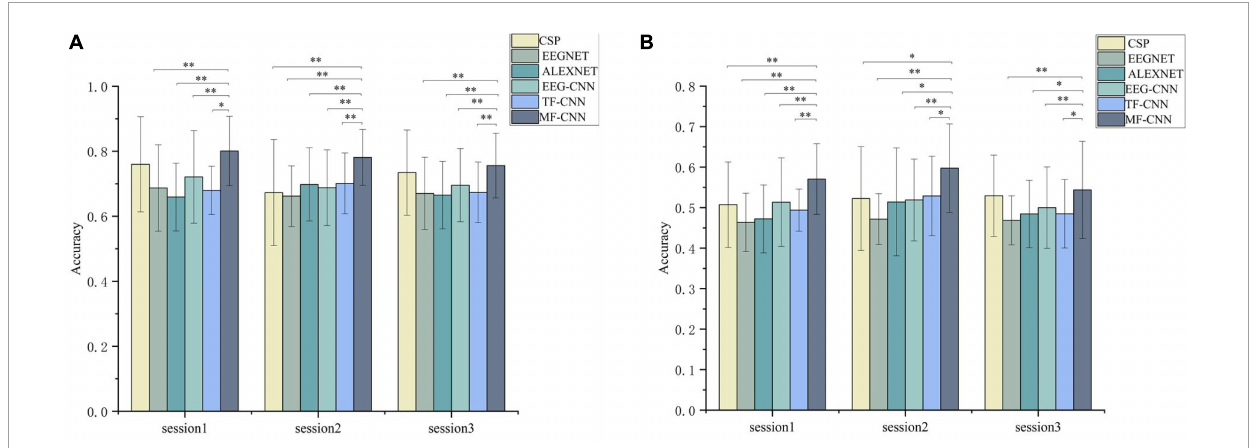
FIGURE5 Comparison of the average classification results on the three sessions. (A) Binary-class classification experiment, (B) three-class classification experiments. ∗ Denotes p < 0.01 and ∗∗ denotes p < 0.001 (paired t- test).